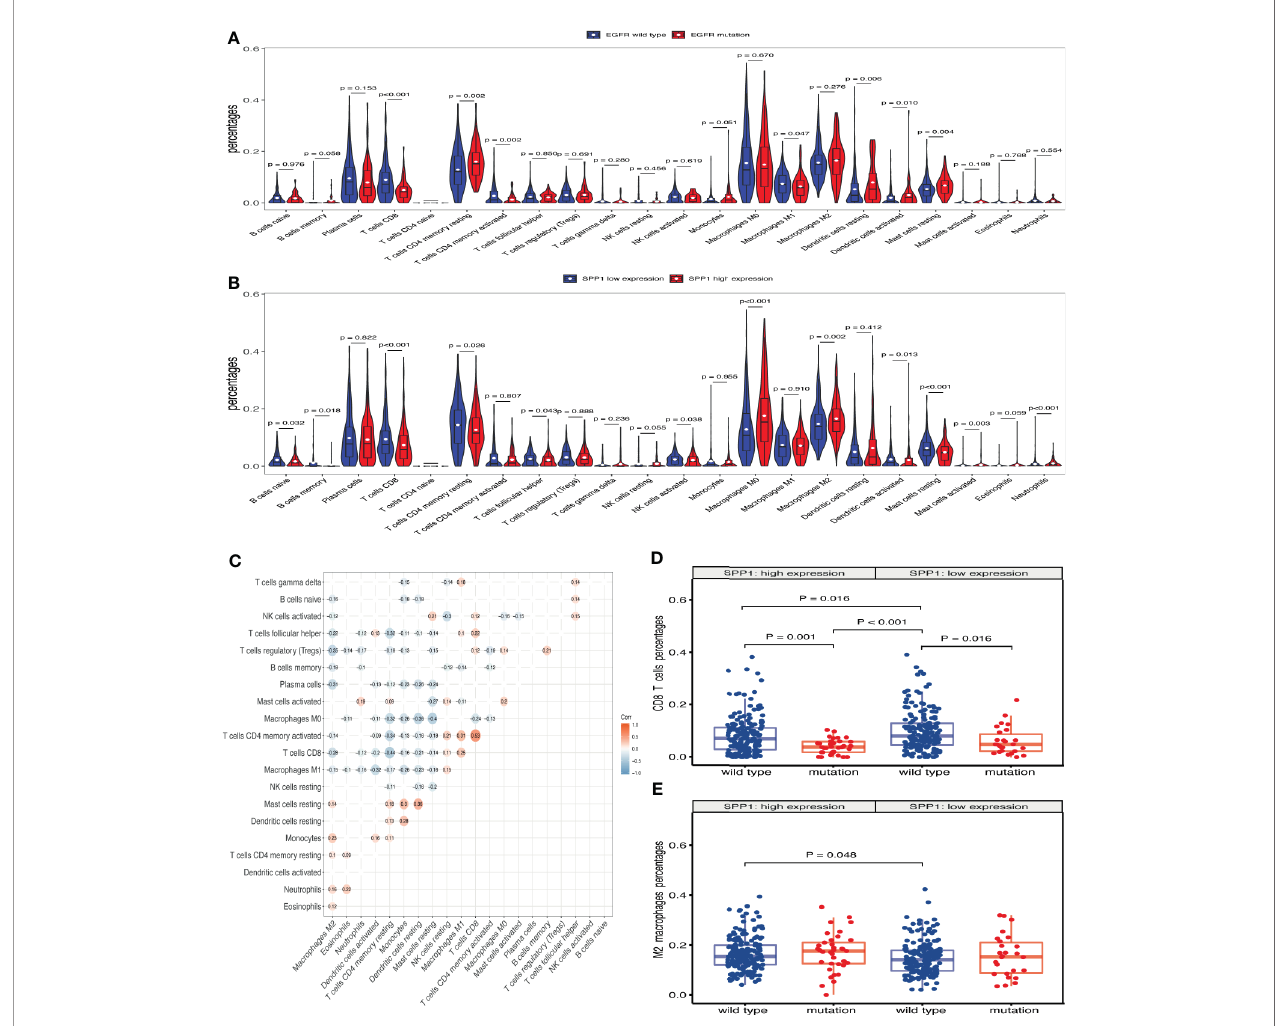
FIGURE 5 | SPP1-related immune in fi ltration alteration. (A) Violin plot showing the ratio differentiation of 22 kinds of TICs in EGFR wild-type and mutant samples. Wilcoxon rank sum was used for the signi fi cance test. (B) Violin plot showing the ratio differentiation of 22 kinds of TICs in low and high SPP1 expression groups. (C) The correlation between different TICs subpopulations. (D) Differences in CD8+ T cells in fi ltration between EGFR mutation and wild-type patients with SPP1 high- or low-expression group. (E) Differences in M2 macrophages in fi ltration between EGFR mutation and wild-type patients with SPP1 high- or low-expression